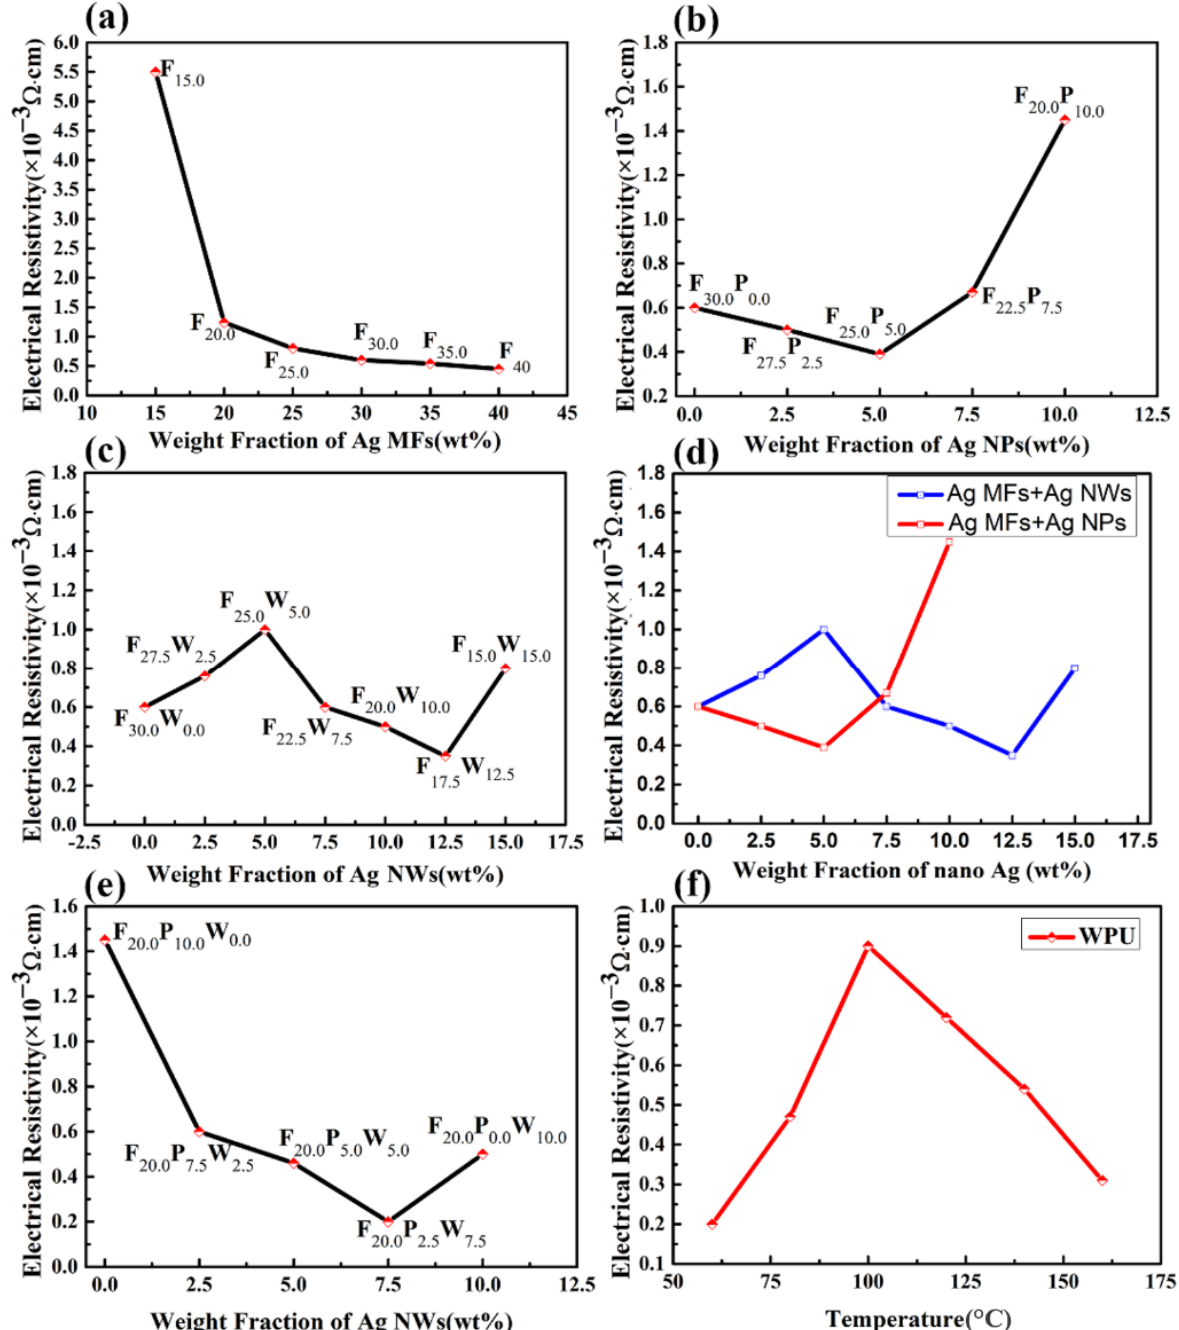
Figure 3. ( a ) ER of the conductive silver paste filled only with Ag MFs after curing at 60 °C, ( b ) ER of the binary mixture conductive silver paste containing Ag MFs and Ag NPs after curing at 60 °C, ( c ) ER of the binary mixture conductive silver paste containing Ag MFs and Ag NWs after curing at 60 °C, ( d ) ER comparison of two binary mixture conductive silver pastes after curing at 60 °C, ( e ) ER of ternary mixture conductive silver paste containing Ag MFs, Ag NPs and Ag NWs after curing at 60 °C, and ( f ) ER of the sample F 20.0 P 2.5 W 7.5 using WPU as the binder at different curing temperatures.